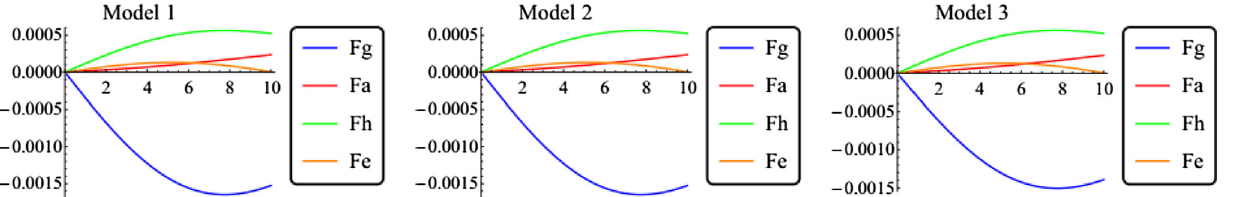
Fig. 10 Thevariationofhydrostaticforce( F h ),gravitationalforce( F g ),anisotropicforce ( F a ) andelectricforce F e underconsiderationofdifferent viable f ( G )